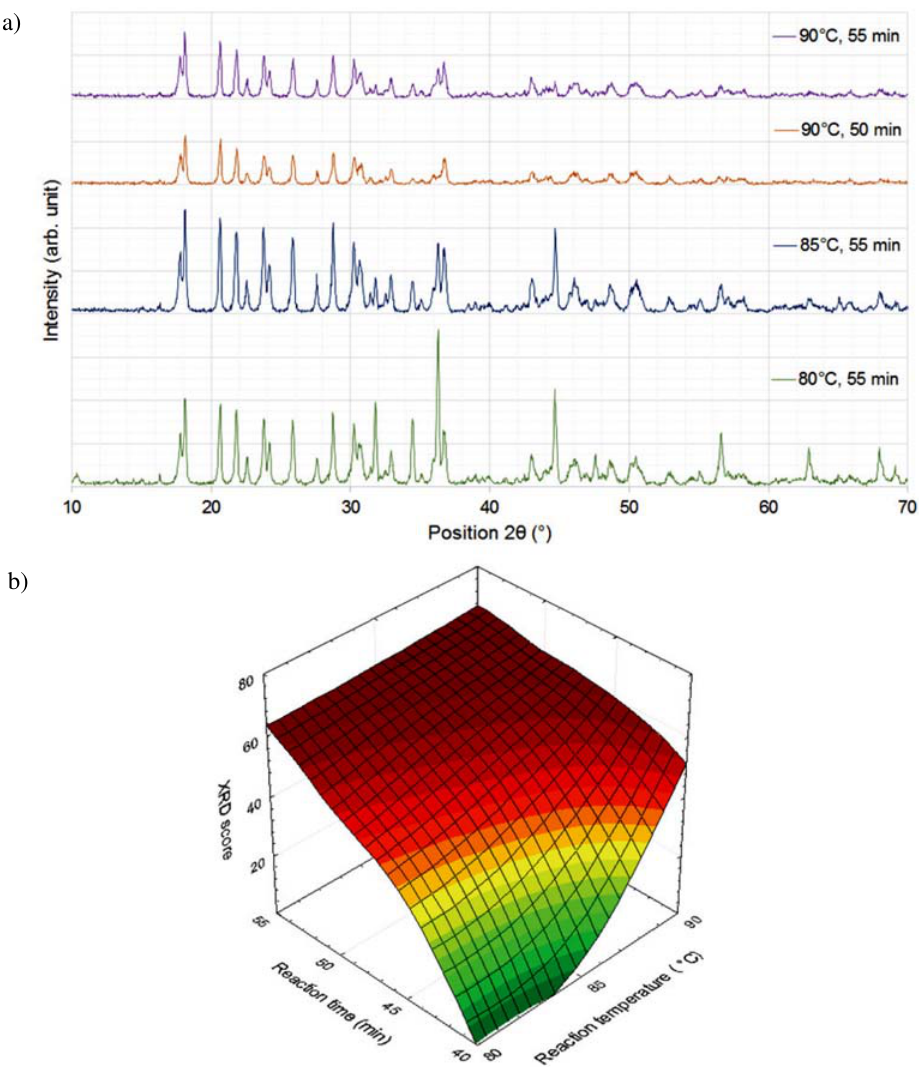
Fig. 2. a. XRD patterns of the synthesized pure zinc borates, b. XRD score graph with respect to reaction temperature and reaction